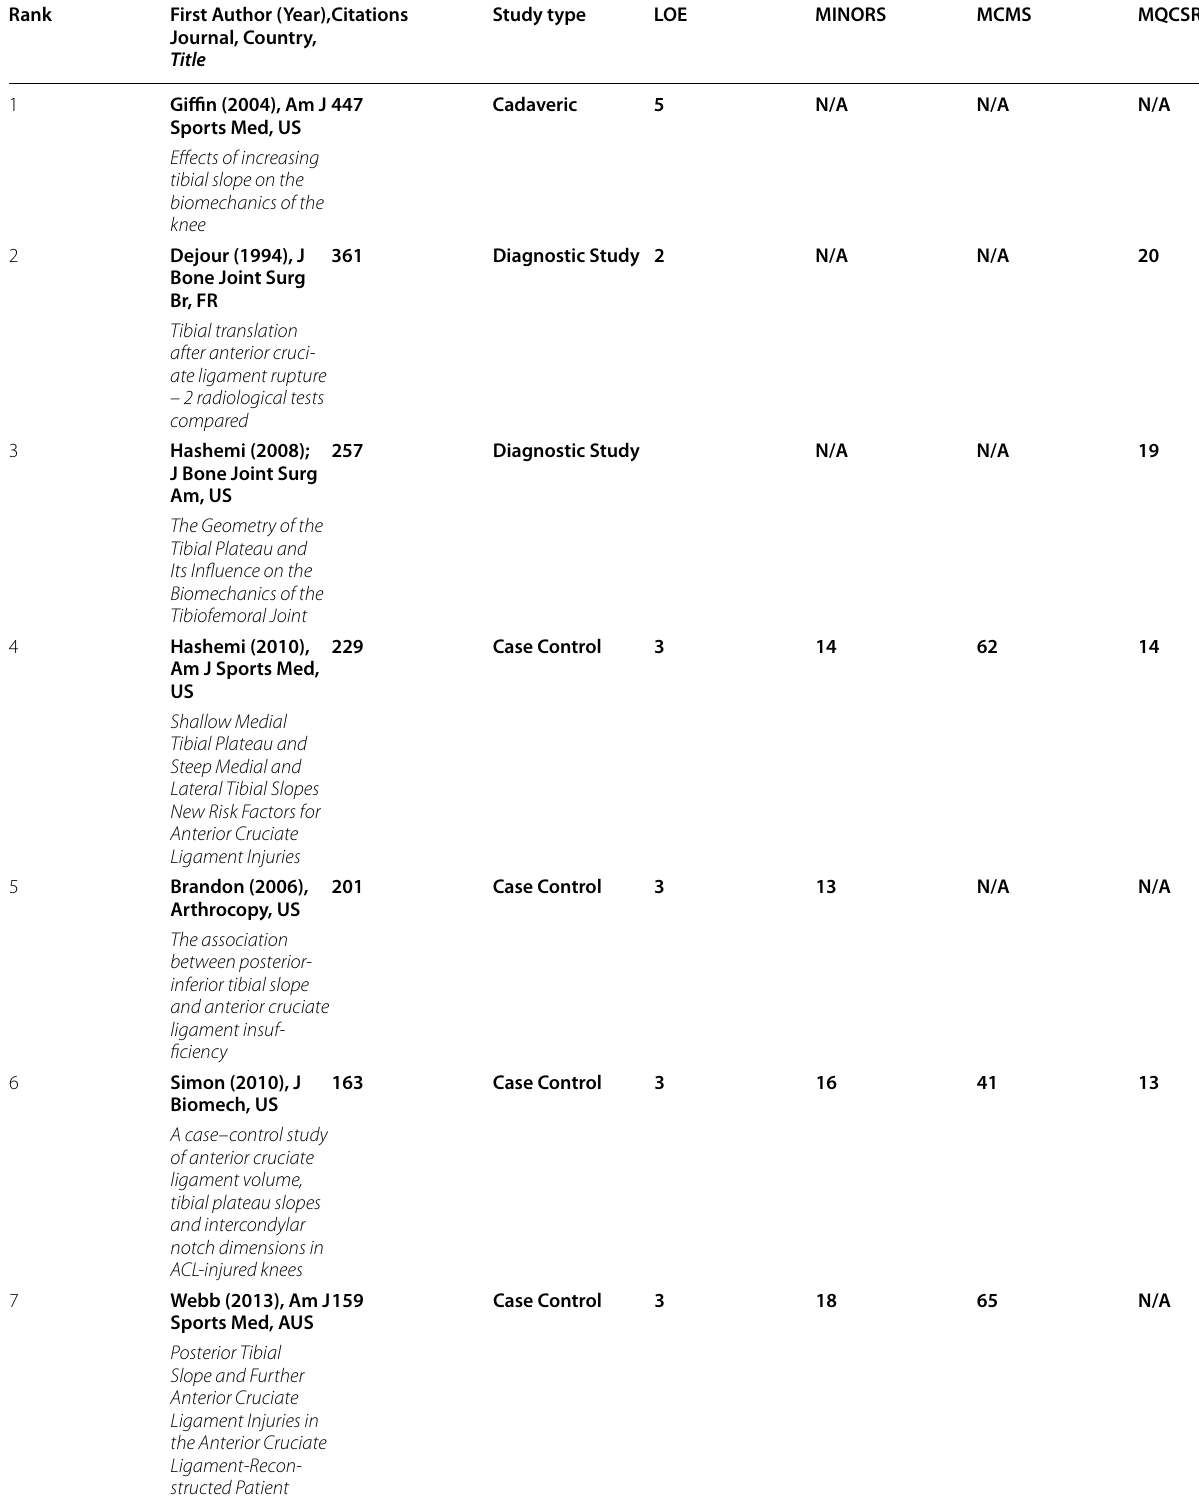
Table 1 Comprehensive list of the 50 most cited studies on posterior tibial slope Rank First Author (Year), Journal,